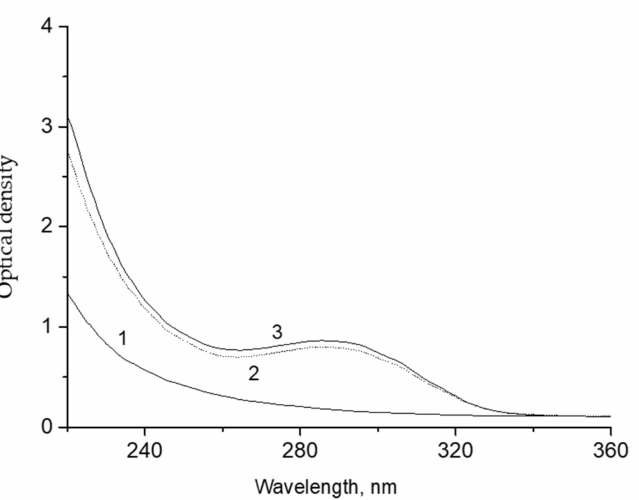
Figure 4. UV spectra of the initial decalin ( 1 ), decalin phase after extraction with water ( 2 ), and decalin phase after ozonation for 19 min ( 3 ). Optical path, 5